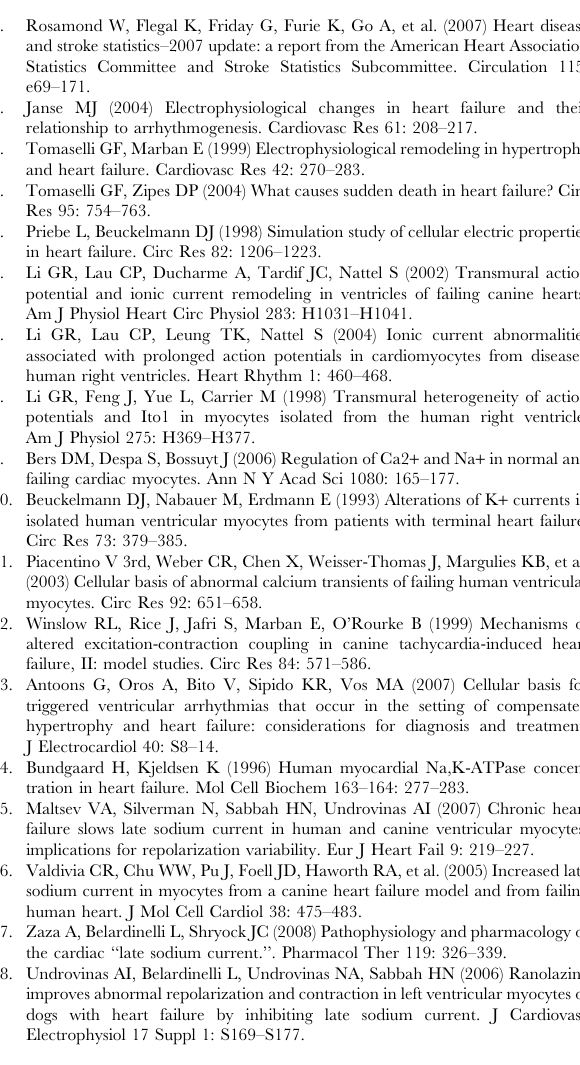
basic HF value of I NCX (dark line) and when I NCX was 50% blocked (light line). (TIF) Figure S15 Mechanisms for early afterdepolarizations with a 50% transitory block of I NCX . Simulated APs and ionic currents at 1-Hz pacing rate under HF conditions, 50% inhibition of I Kr , 30% increase of I CaL . Panel A shows EADs (dark line) with the basic HF value of I NCX and APs with no EADs when I NCX was 50% blocked (light line during the 5 stimulations indicated by a horizontal line. The temporal evolutions of I NaL (panel B), [Ca 2 + ] SR (panel C), I rel (panel D), NCX activity (panel E), and activation gate of I CaL (panel F) are also depicted with the basic HF value of I NCX (dark line) and when I NCX was 50% blocked (light line) during the 5 stimulations indicated by a horizontal line.